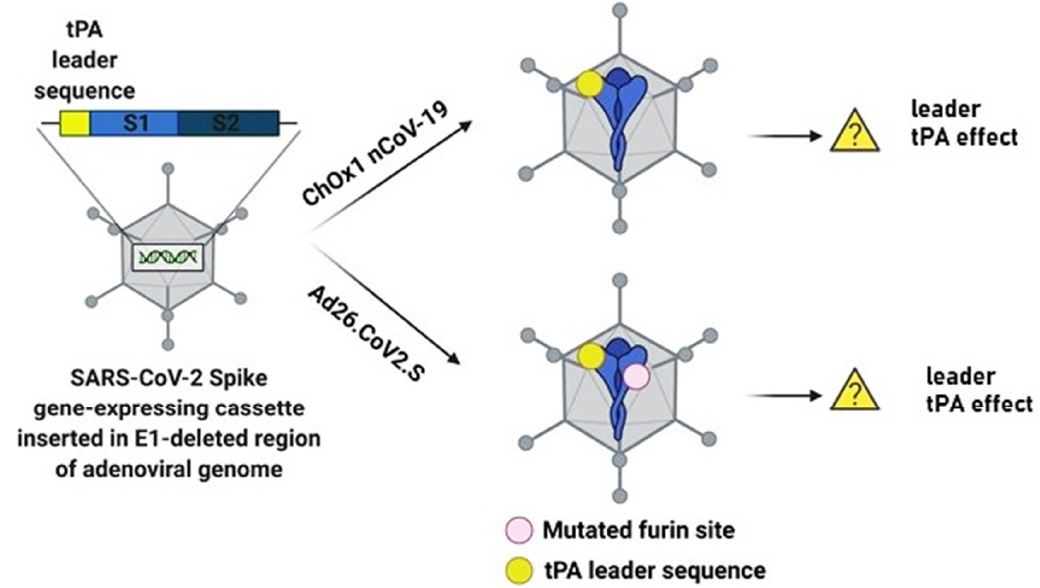
Figure 1. Schematic illustration of ChAdOx1 nCoV-19 and Ad26.COV2.S constructs and the potential association of tPA and thrombocytopenia. Both ChAdOx nCoV-19 and Ad26.COV2.S contain the tPA leader sequence and the full-length SARS-CoV-2 protein. Ad26.COV2.S additionally has a mutated furin site. The translation of only the tPA leader sequence is unlikely to cause thrombocytopenia as previously reported in ischemic stroke and acute myocardial infarction patients treated with recombinant tPA. Figure was created with Biorender.